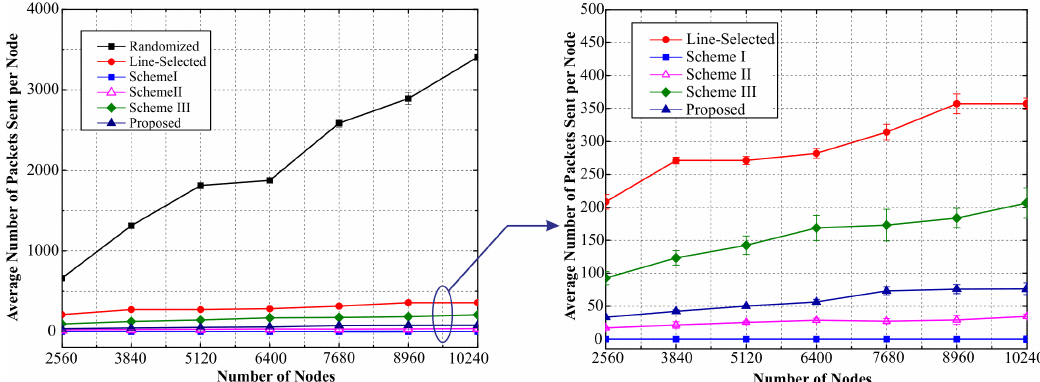
Figure 13. Communication overhead of the proposed and previous works.